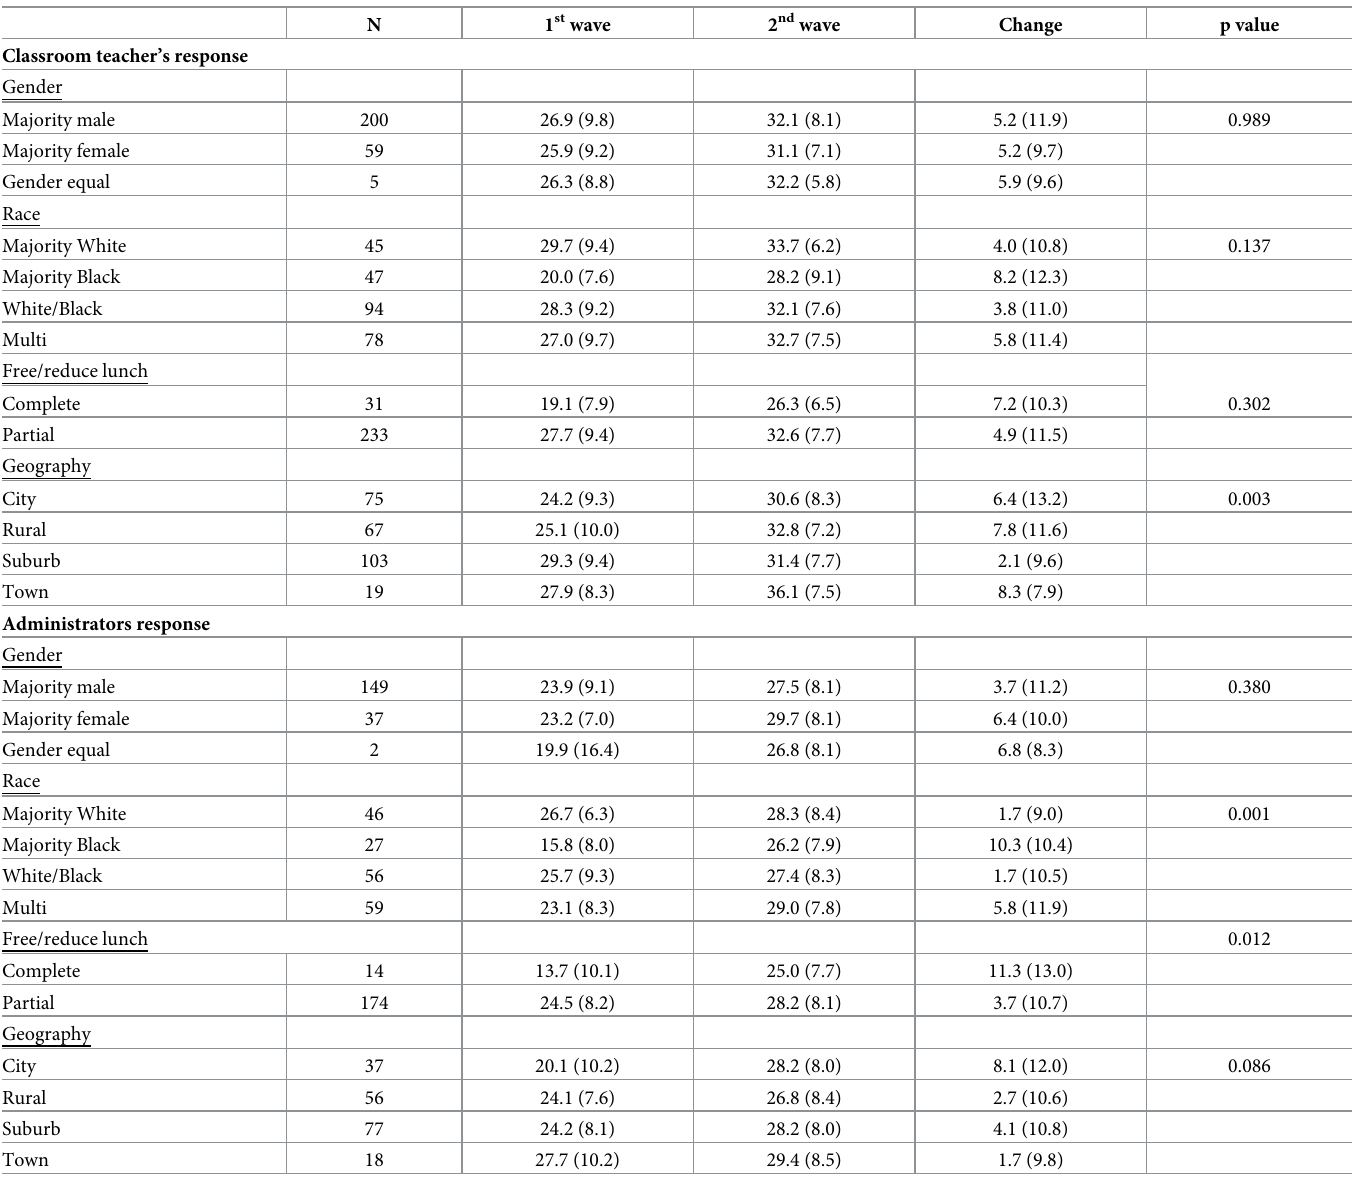
Table 3. Mean total physical activity in minutes per day (SD) by school characteristics.